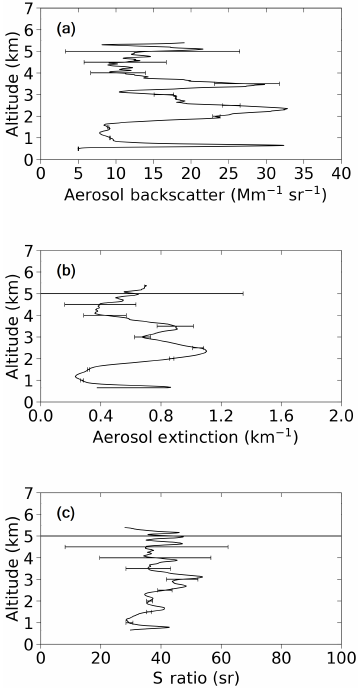
Figure 22. One-hour average between 10:00 and 11:00UTC on 8 September for (a) backscatter coefficient, (b) extinction coeffi- cient and (c) S ratio. The effective resolution is the same as Fig. 17.